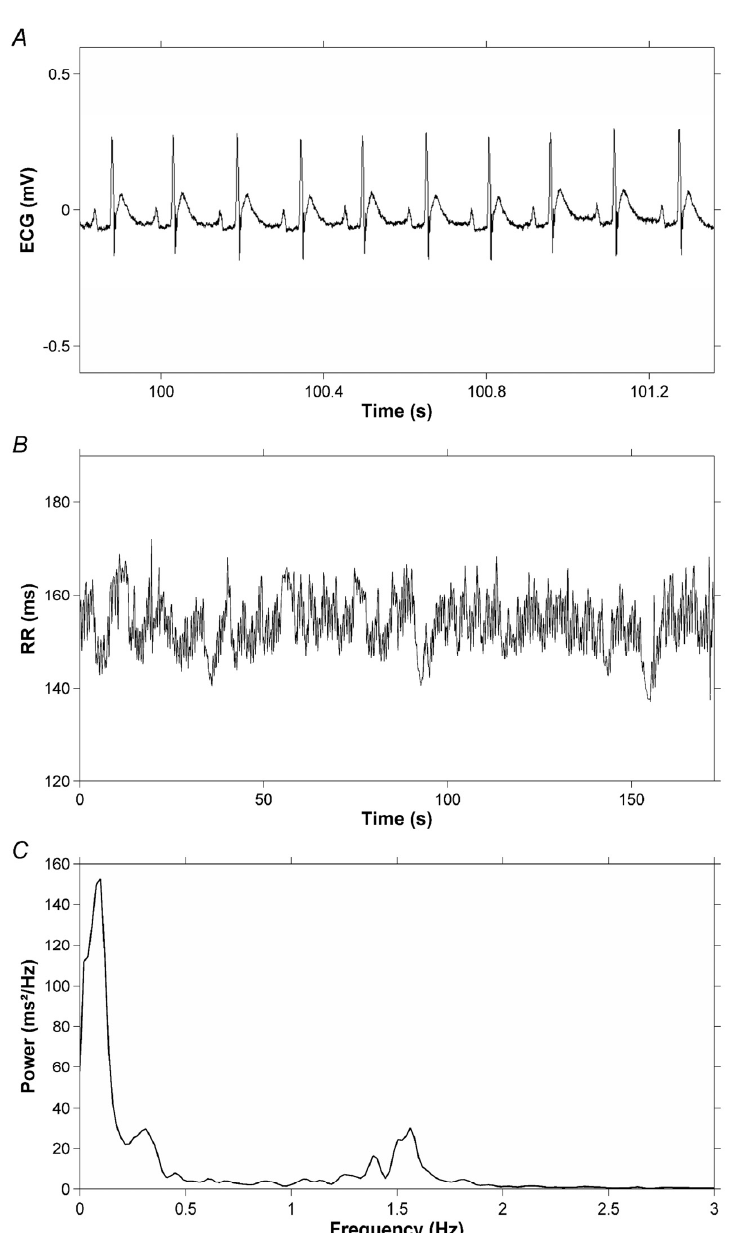
Fig. 2 – HRV graphs extracted from one animal: A – Non-filtered ECG segment tracing. B – Tachogram. C – Power spectrum of RR